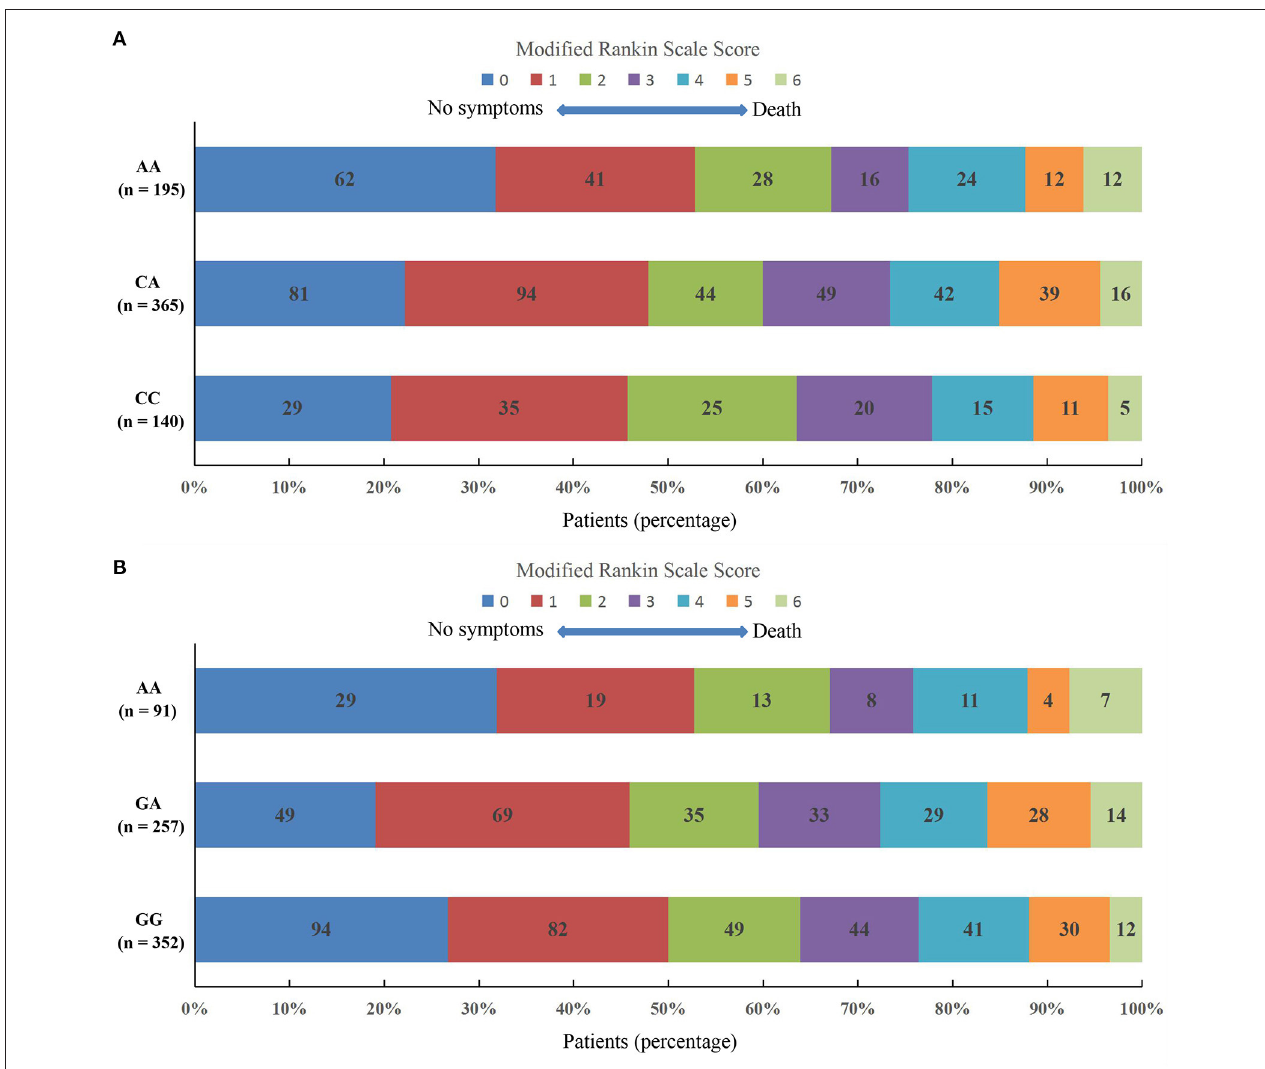
FIGURE 3 | Scores on the modified Rankin Scale at 3 months in ischaemic stroke patients with metabolic syndrome across the polymorphisms of rs4685423 and rs4618210. There was no significantly different shift in the distribution of the mRS scores across the polymorphisms of rs4685423 ( A , F = 1.146, P = 0.319) or rs4618210 ( B , F = 1.919, P =